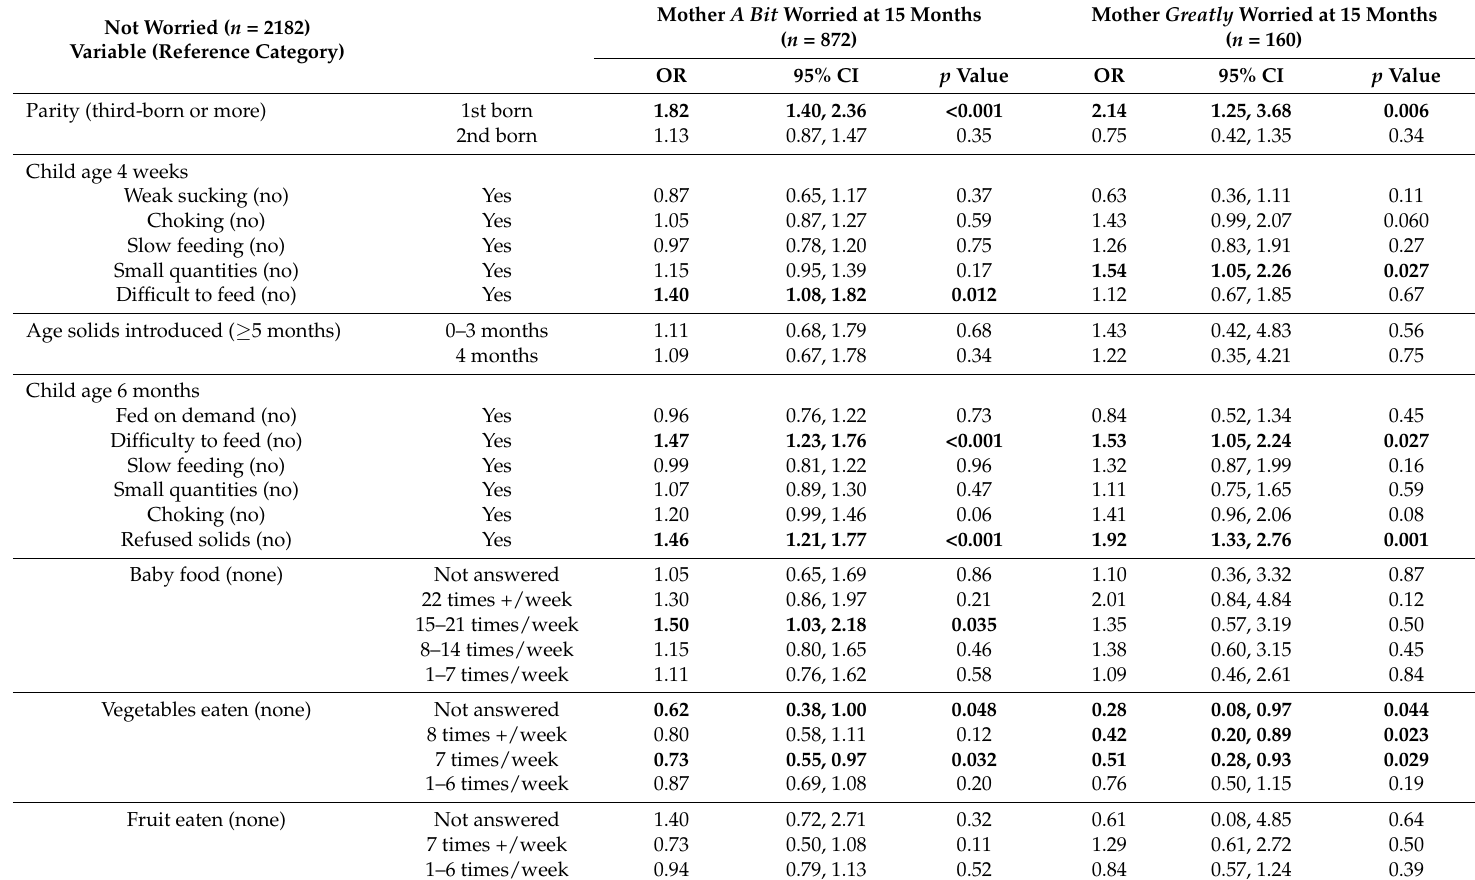
Table 2. Factors associated with maternal worry about her child being choosy at 15 months of age. Not Worried ( n = 2182) Variable (Reference